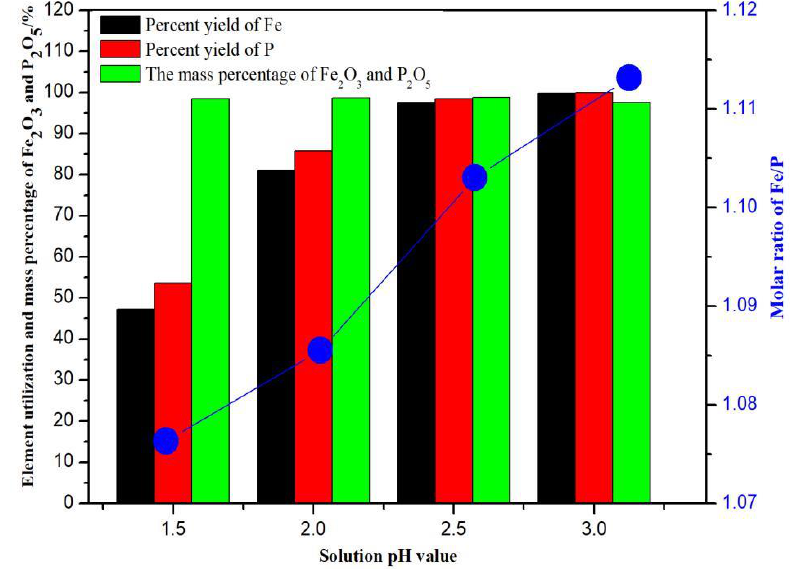
Figure 8. The e ff ect of the initial pH value on the utilization ratio of the elements / purity and the molar Figure 8. The effect of the initial pH value on the utilization ratio of the elements/purity and the molar ratio of Fe / P in iron ratio of Fe/P in iron phosphate.